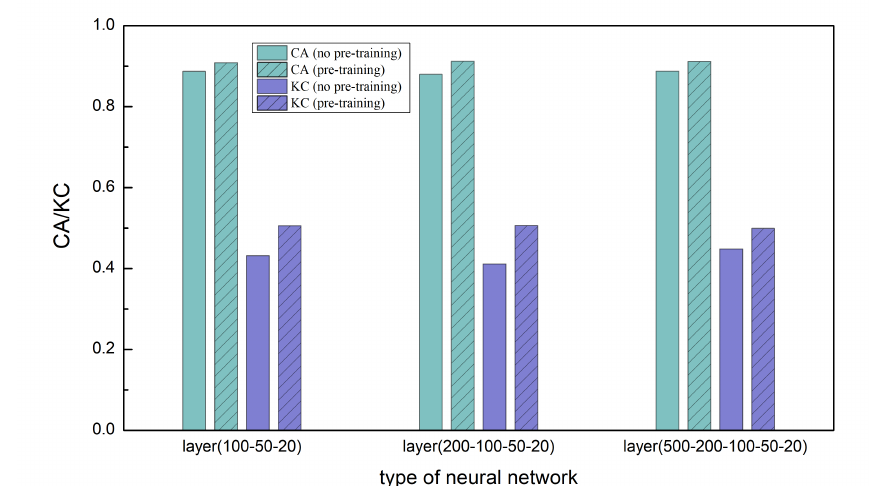
Figure 16. Comparison results of the influence of pre-training on change detection.